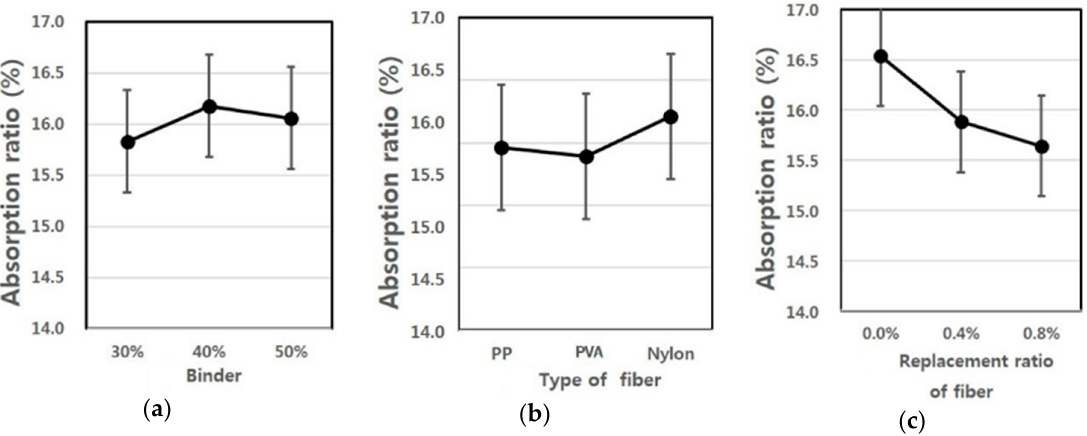
Figure 8. Assumed absorption ratio of extrusion panel by variance analysis: ( a ) replacement ratio of binder; ( b ) type of fiber; ( c ) replacement ratio of fiber.